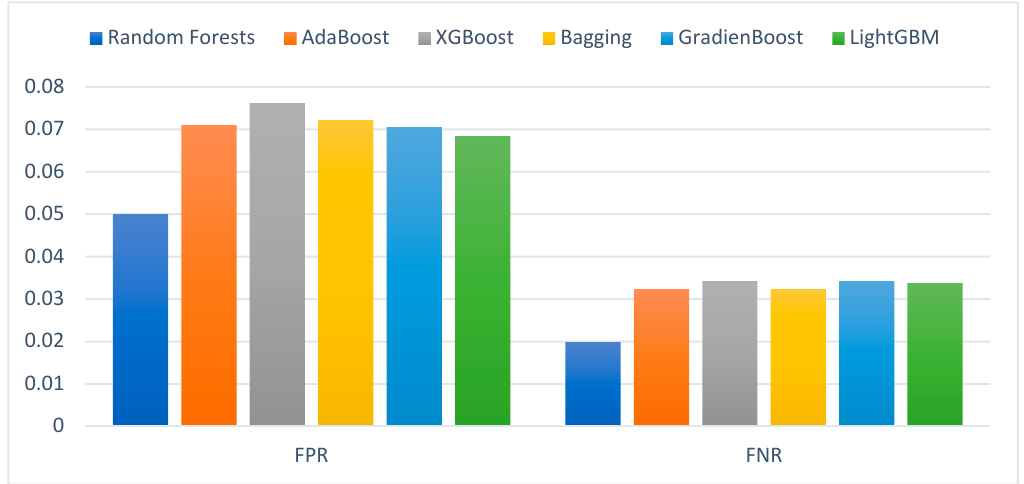
Figure 2. Comparisons of the FPR and FNR of ensemble methods for Dataset 1 . Table 3. Performance of ensemble classifiers for Dataset 2 .